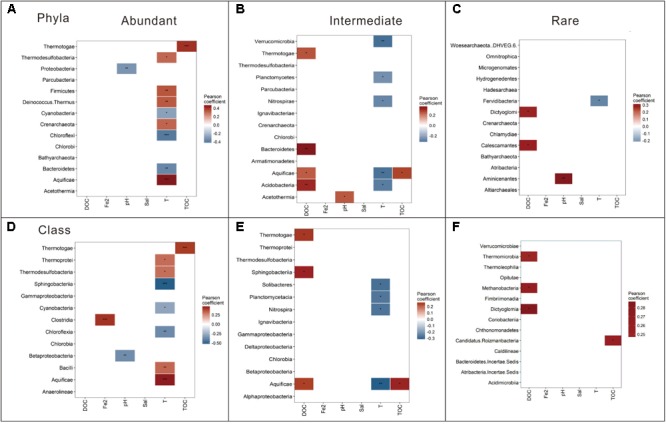
Pearson correlation between the relative abundance of the dominant taxa (at the phylum and class levels) and the measured environmental variables for the abundant (A,D), intermediate (B,E), and rare (C,F) biospheres. ∗∗∗p < 0.001; ∗∗p < 0.01; and ∗p < 0.05; Sal, salinity; DOC, dissolved organic carbon; TOC, total organic carbon; Fe2, Fe2+.